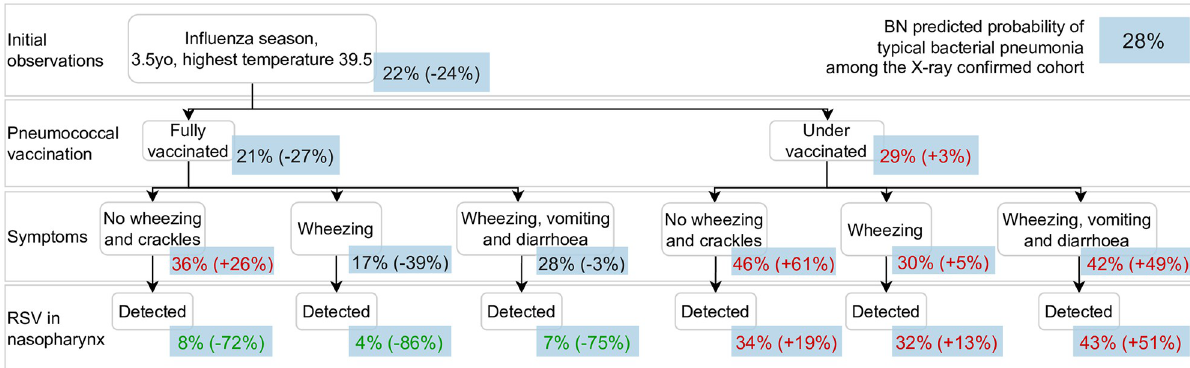
Fig 11. Clinical scenario 3, BN v4.5. This scenario shows a pre-school aged ( age group (1) ) child with X-ray confirmed pneumonia and very high temperature ( highest temperature (37) ) during the influenza season (9) . The probability of typical bacterial pneumonia ( causative pathogen for pneumonia (25) ) increases if the child is under-vaccinated for pneumococcus ( Pneumococcal vaccine (10) ), regardless of whether RSV is detected from their nasopharynx or not ( RSV in nasopharynx (16) ). If fully-vaccinated, the presence of wheezing (43) will lead to a decrease in the predicted probability of typical bacterial pneumonia, and this prediction will drop to only 4% if RSV is detected in the child’s nasopharynx. Other variables involved in this scenario are crackles (44) , vomiting (39) and diarrhoea (40)